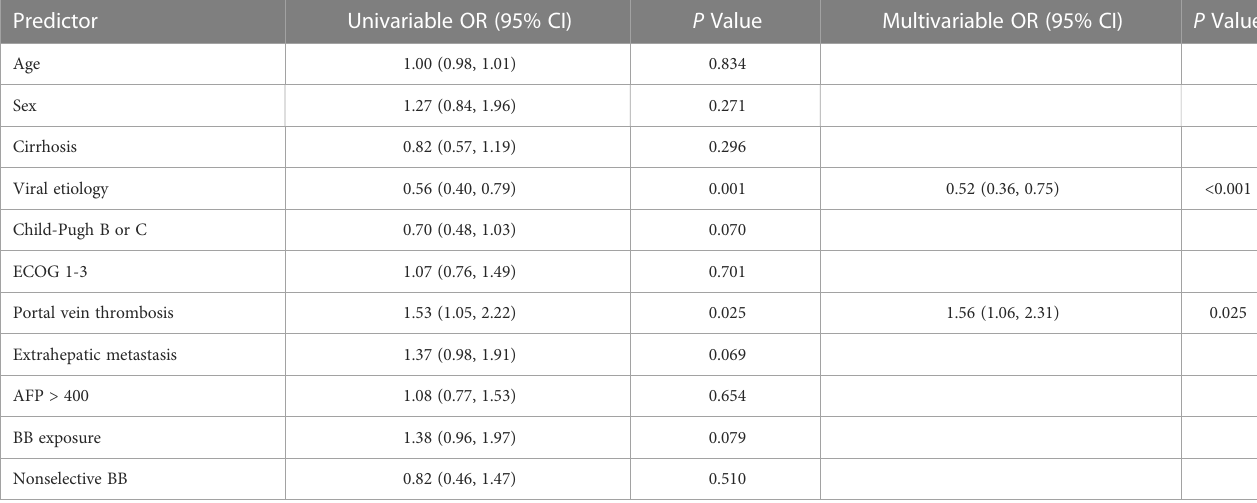
TABLE 6 Univariable and multivariable Cox proportional hazard models for any adverse events. Predictor